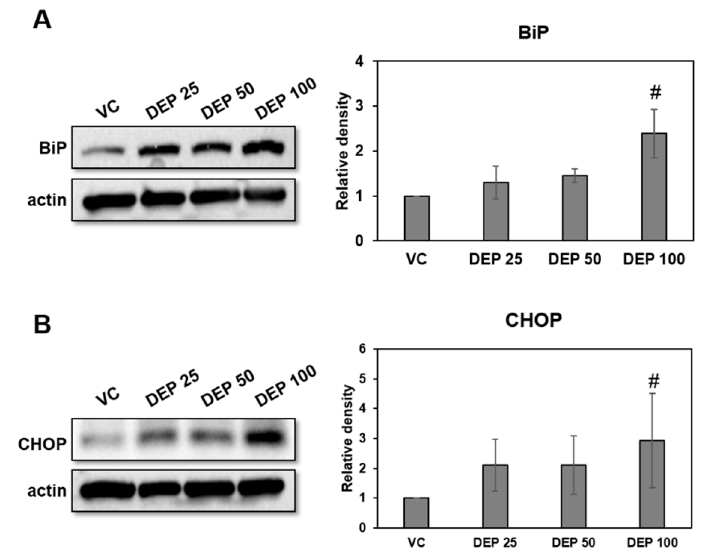
Figure 3. Expression levels of the ER stress markers BiP and CHOP in DEP-induced mice. Representative Western blots and relative densities of ( A ) BiP and ( B ) CHOP in lung tissues of DEP-induced mice. Mice were treated three times by DEP and sacrificed at day 9. Data are means ± SD ( n = 5 per group). # p < 0.05 vs vehicle control.